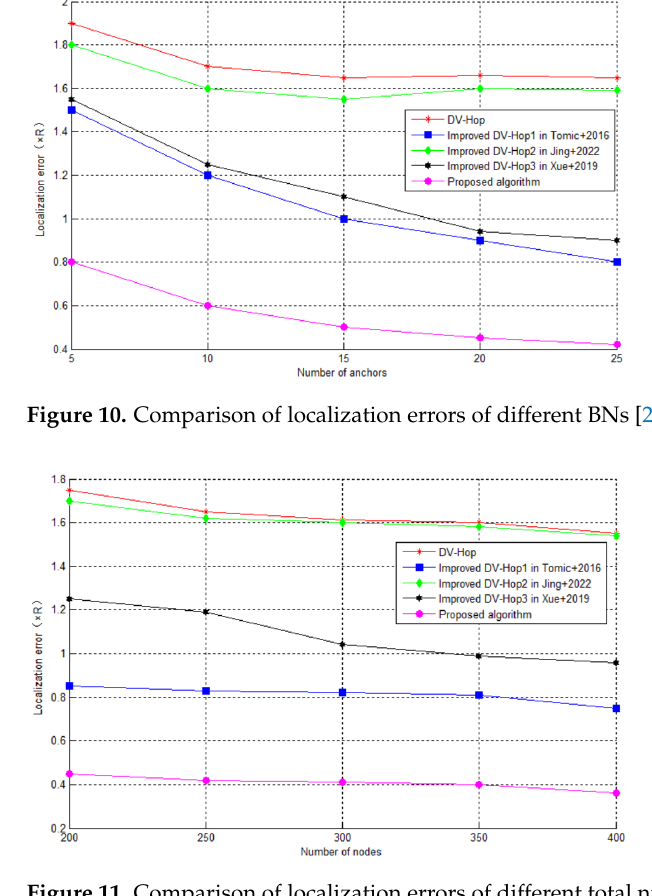
Figure 9. Comparison of localization errors in different communication radius [21][22][23].